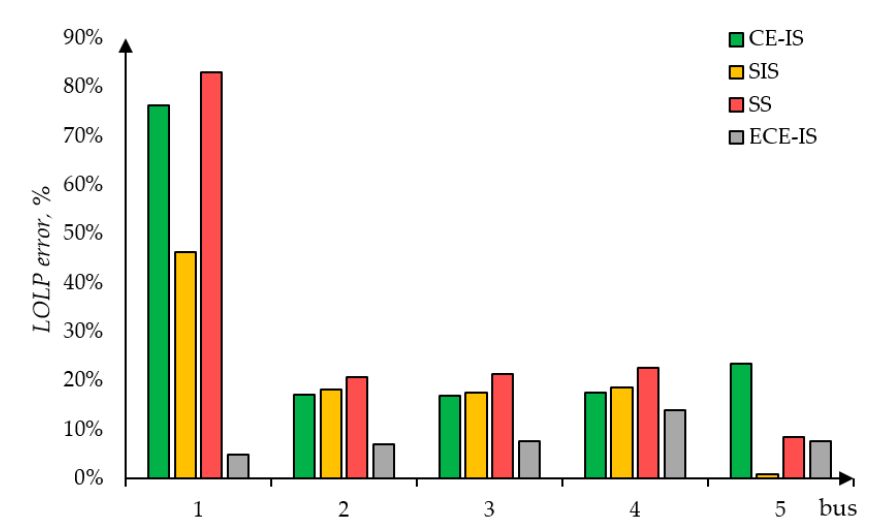
Figure 9. LOLP error compared to the standard MCS method.